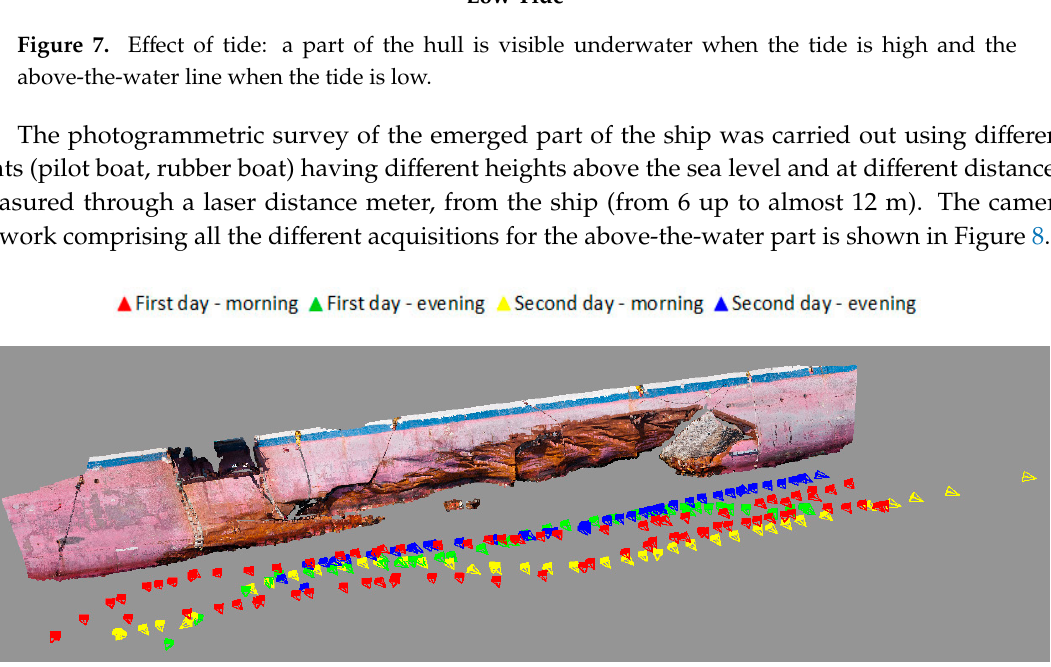
Figure 7. Effect of tide: a part of the hull is visible underwater when the tide is high and the above-the-water line when the tide is low.